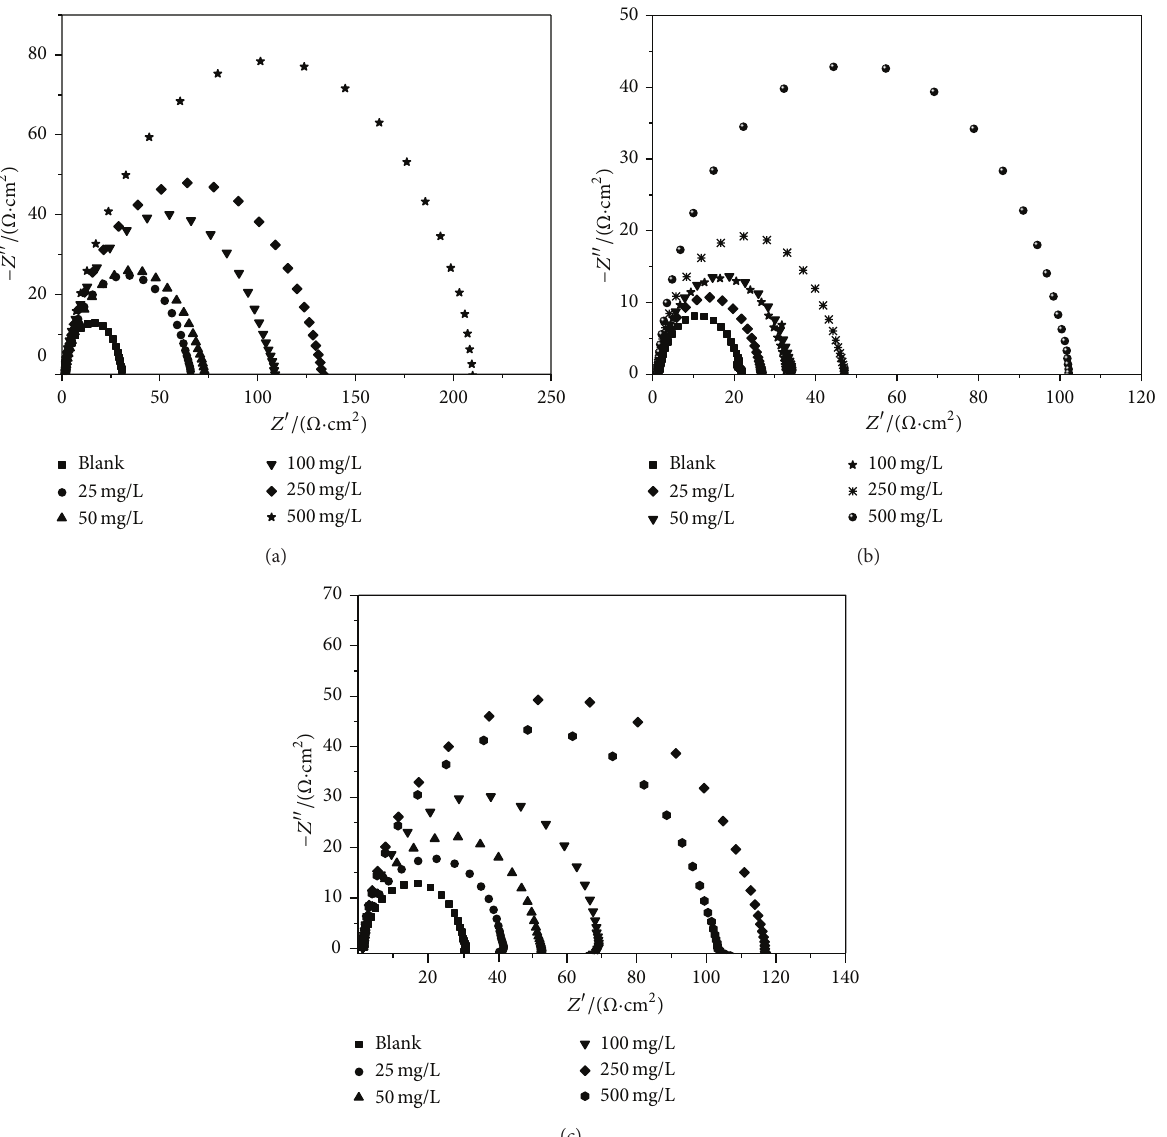
Figure 6: (a) Nyquist plots obtained for mild steel in 1M HCl in the presence and absence of different concentrations of PoAP. (b) Nyquist plots obtained for mild steel in 1 M HCl in the presence and absence of different concentrations of PmAP. (c) Nyquist plots obtained for mild steel in 1M HCl in the presence and absence of different concentrations of